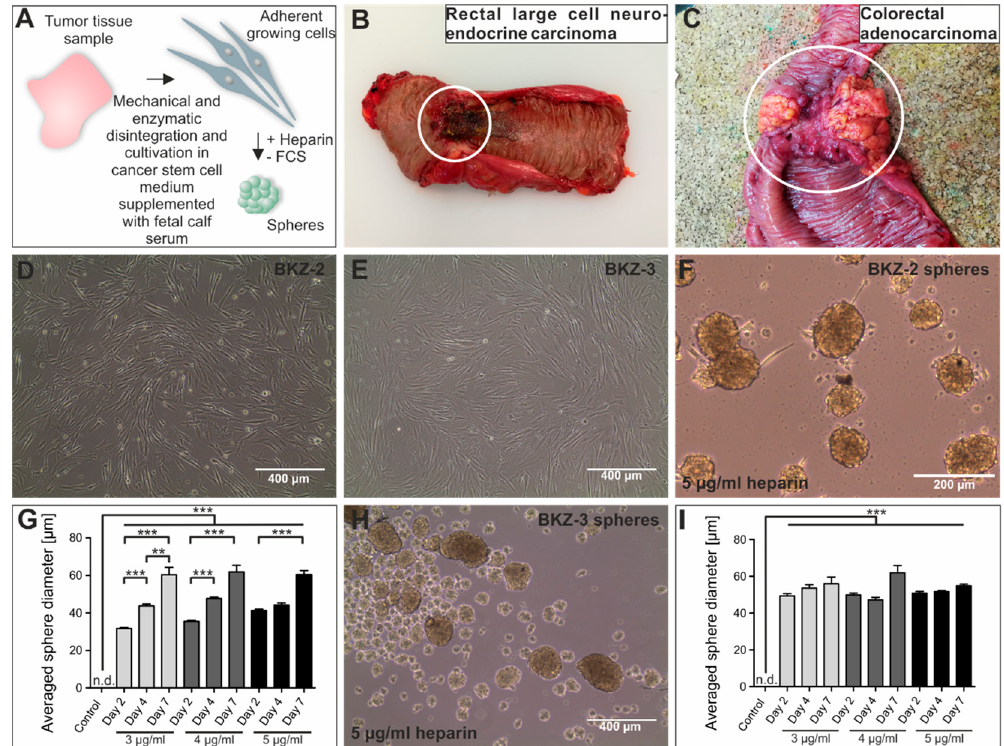
Figure 3. Successful isolation of the rectal large cell neuroendocrine carcinoma (NEC)-derived cancer cell line BKZ-2 and the colorectal adenocarcinoma (AC)-derived cancer cell line BKZ-3. ( A ) For the isolation of those cell lines that contain a subpopulation of cells with potential stem-like properties a tissue sample of either the ( B ) rectal large cell NEC or the ( C ) colorectal AC was obtained, mechanically and enzymatically disintegrated, and cultivated in CSC medium supplemented with fetal calf serum (FCS), leading to ( D / E ) adherent growing cells. ( F / H ) Cultivation of the cells with the addition of heparin and in the absence of FCS led to the formation of spheres, further validating stem-like properties of BKZ-2 and BKZ-3. ( G / I ) Quantification of the averaged sphere diameter showed a significant increase after the addition of heparin in comparison to the control for BKZ-2 and BKZ-3, regardless of the tested heparin concentrations. Moreover, BKZ-2 showed a continuous growth of the spheres over a time-period of one week. Non-parametric Kruskal-Wallis test ( p ≤ 0.05), followed by Dunn’s Multiple Comparison post-hoc test. n = 5, *** p ≤ 0.001, ** p ≤ 0.01. Mean ± standard error of the mean (SEM). n.d. = not detectable.